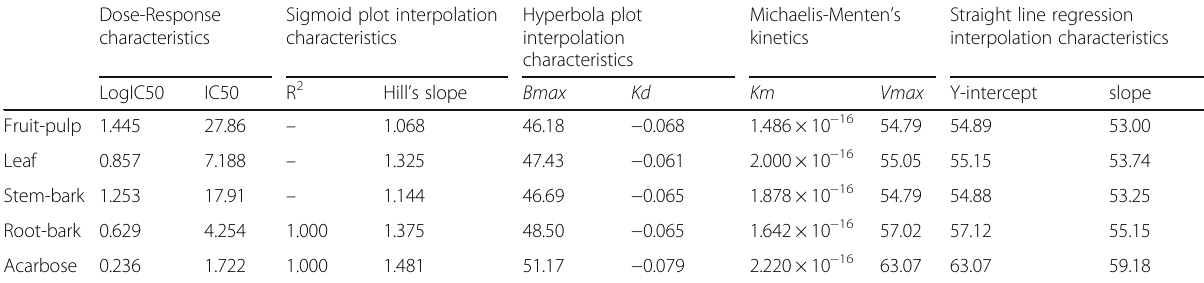
Table 8 Dose-response characteristics of the influence of Annona muricata dichloromethane extracts on α -glucosidase activity Dose-Response Sigmoid plot interpolation Hyperbola plot characteristics characteristics interpolation